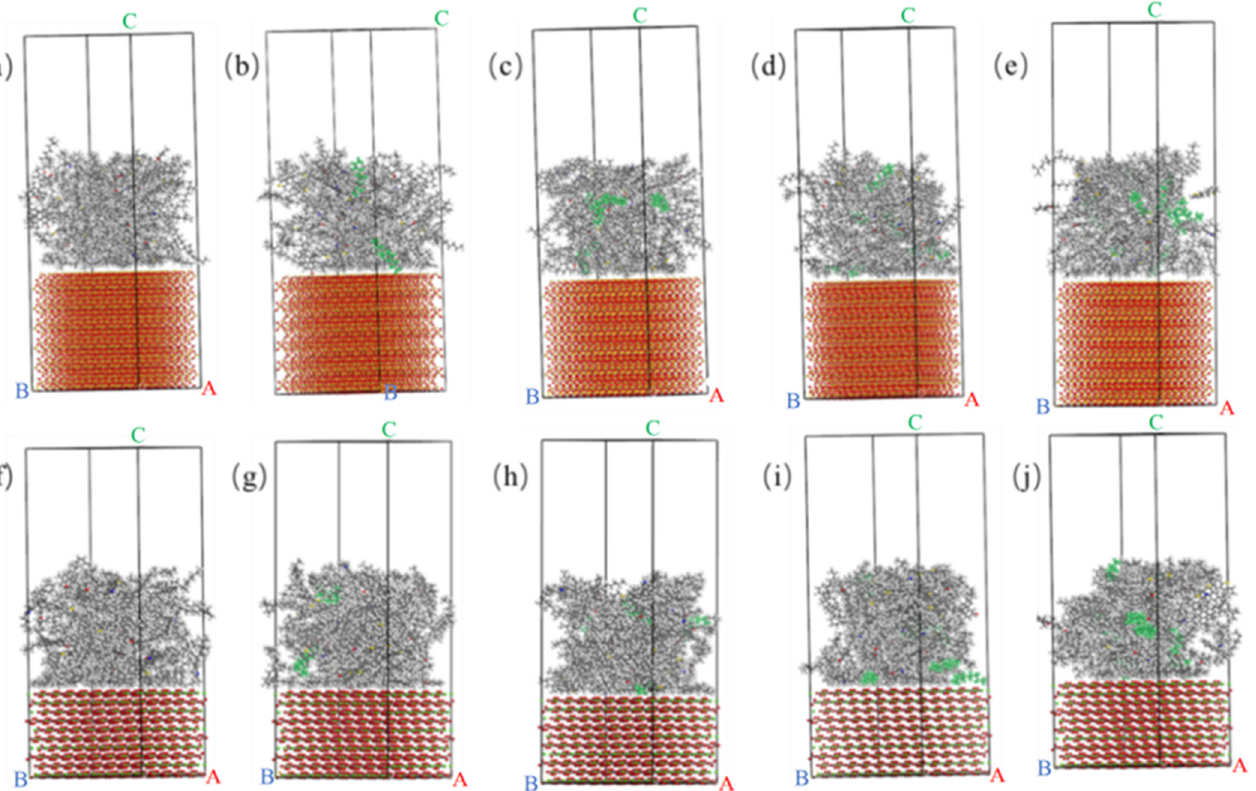
Figure 11. ( a ) Matrix asphalt and SiO 2 interface model; ( b ) WWMA-1 and SiO 2 interface model; ( c ) WWMA-2 and SiO 2 interface model; ( d ) WWMA-3 and SiO 2 interface model; ( e ) WWMA-4 and SiO 2 interface model; ( f ) MA and CaCO 3 interface model; ( g ) WWMA-1 and CaCO 3 interface model; ( h ) WWMA-2 and CaCO 3 interface model; ( i ) WWMA-3 and CaCO 3 interface model; ( j ) WWMA-4 and CaCO 3 interface model.